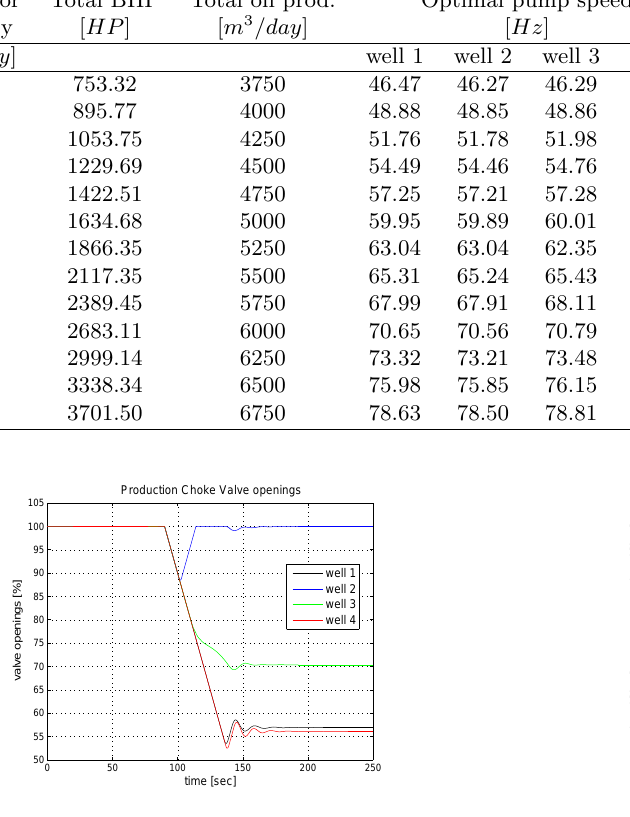
Figure 6: Production choke valve openings for very lower separator capacity